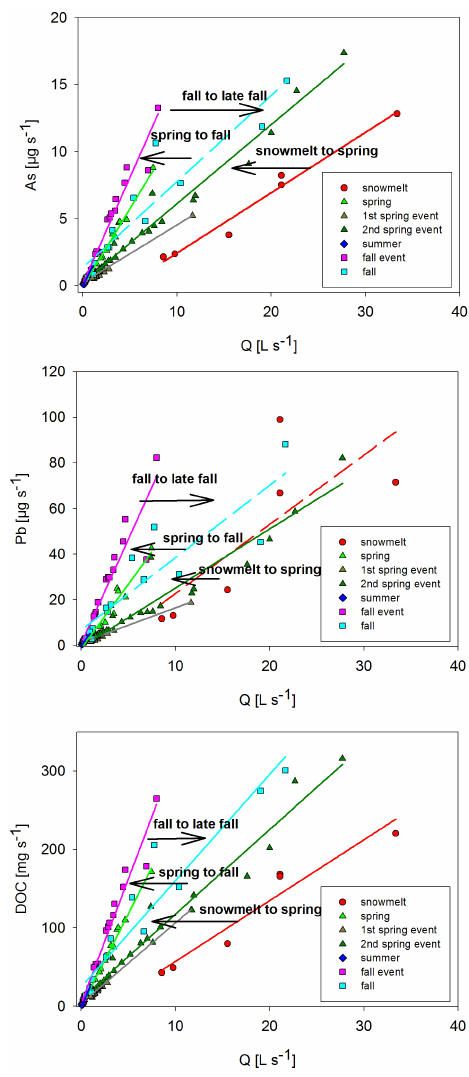
Figure 8. As (top), Pb (middle) and DOC (bottom) loadings to dis- charge ( Q ) plots divided by season and event sampling. Regression lines with R 2 >0.90 are plotted with a solid line, R 2 <0.9 are plot- ted with a dashed